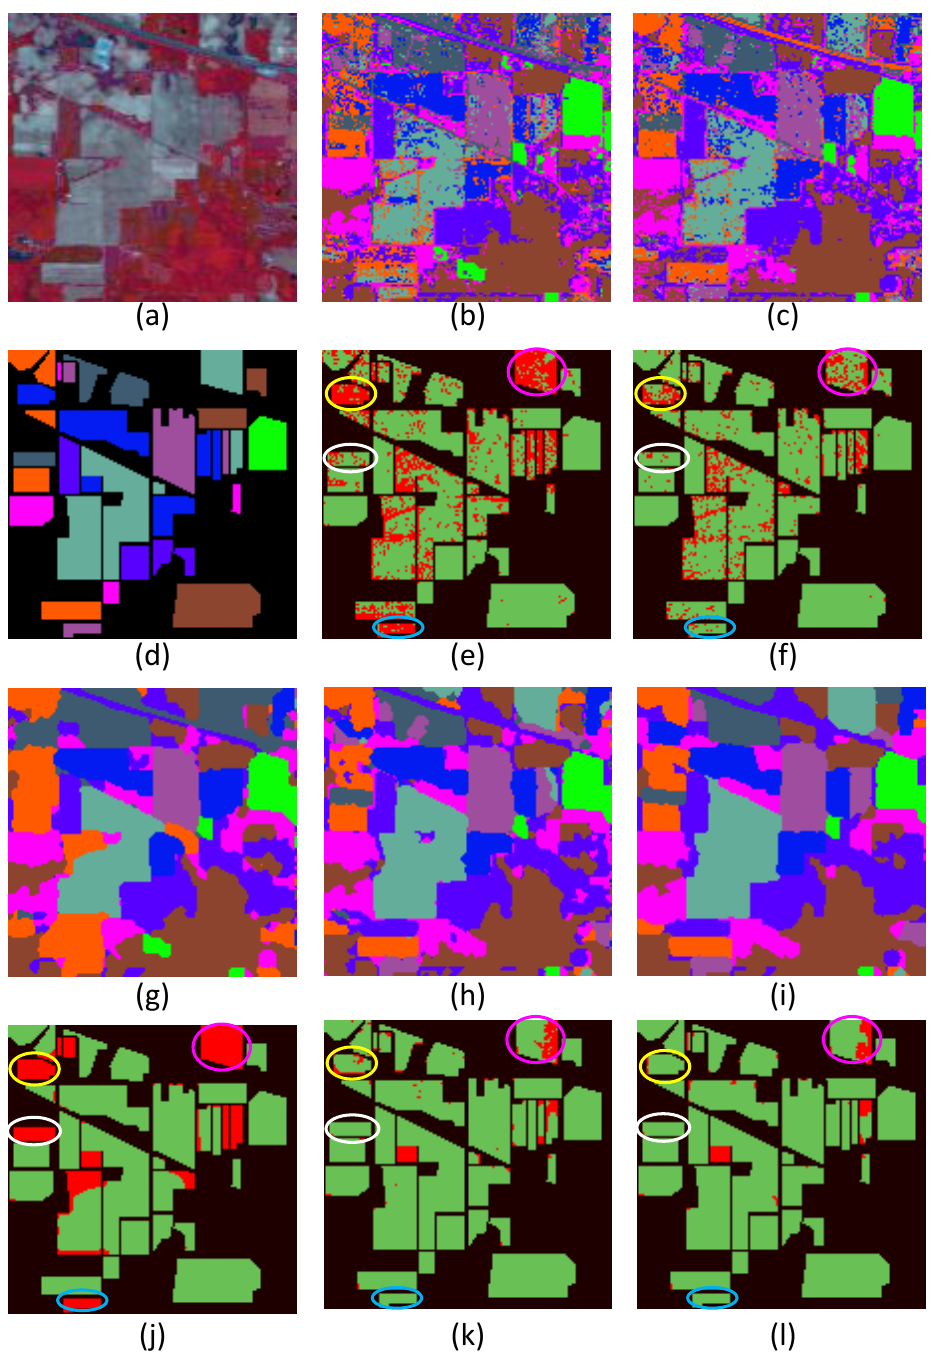
Figure 1. Classification results of the Indian Pines dataset (with 200 training samples for each class). ( a ) Three-band false color image. ( d ) Ground truth. ( b , c , g – i ) Classification maps obtained by multinomial logistic regression (MLR), support vector machines (SVMs), conditional random fields (CRFs), support vector random fields with a Mahalanobis distance boundary constraint (SVRFMC), and higher order support vector random fields (HSVRFs). ( e , f , j – l ) The corresponding difference images of ( b , c , g – i ) compared with the ground truth in ( d ). Black regions represent pixels without ground truth; In the rest of the areas, green regions represent correctly classified pixels and red regions represent wrongly classified